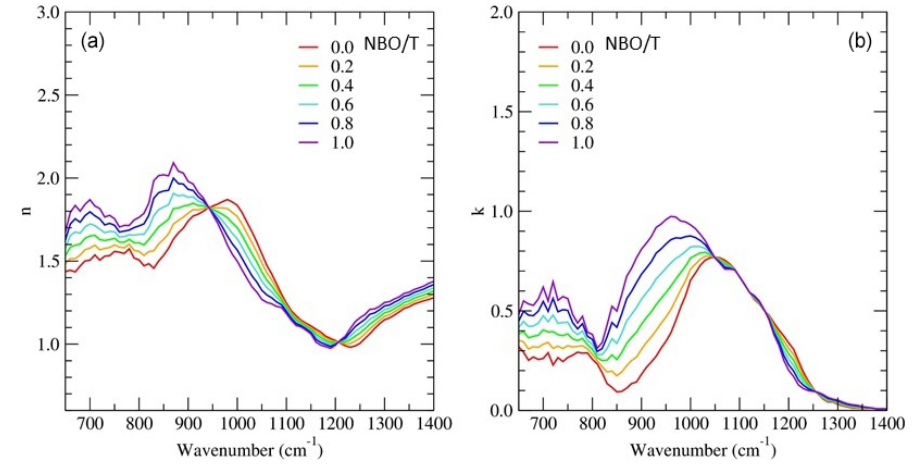
Figure 4. The same as Fig. 3 but for PG2019 RI models parameterized using